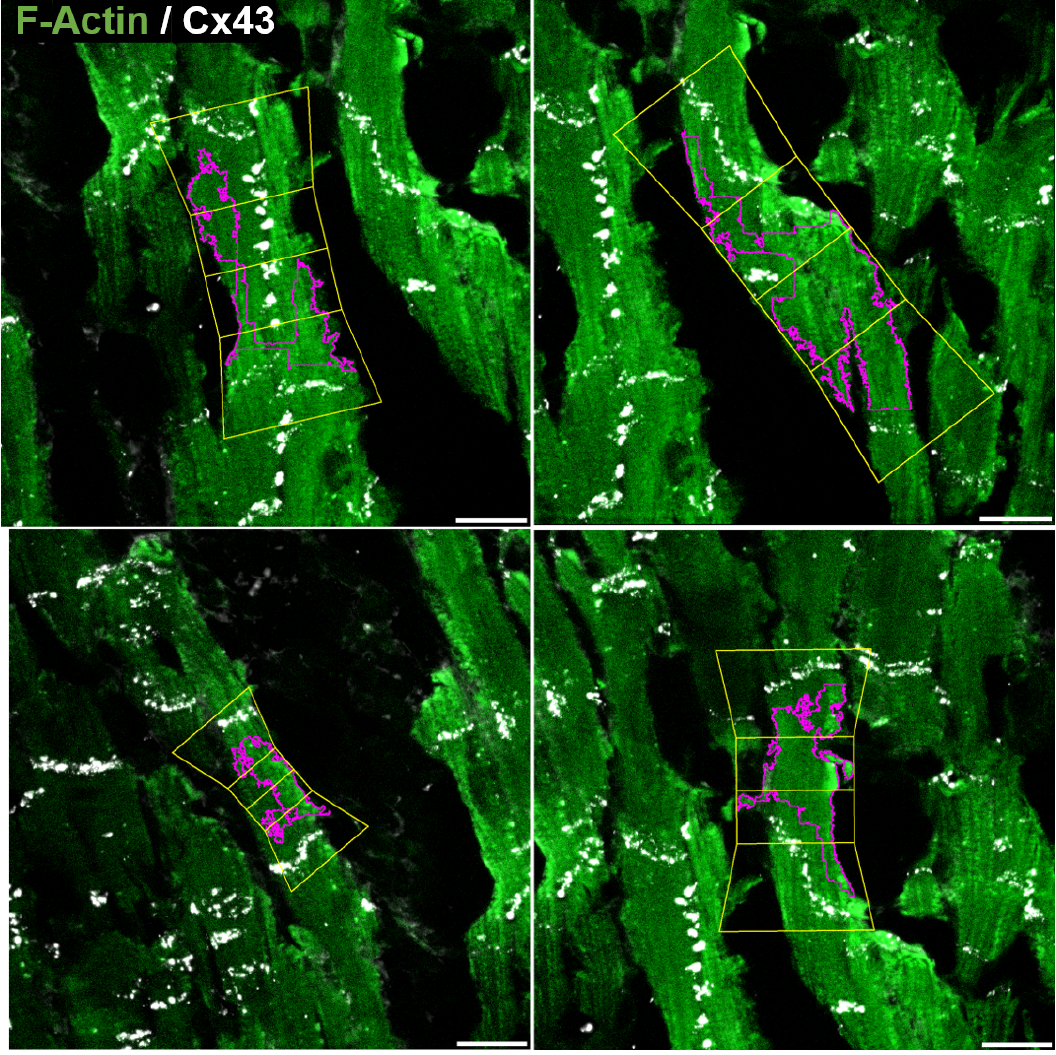
Figure 16. Four detected CMs from the automatic mask M a on top of image e . Morphological measurements and C lat values are provided in Table 3 for e CM ,1 ( top left ), e CM ,2 ( top right ), e CM ,3 ( bottom left ) and e CM ,4 ( bottom right ). Scale bar = 20 µ